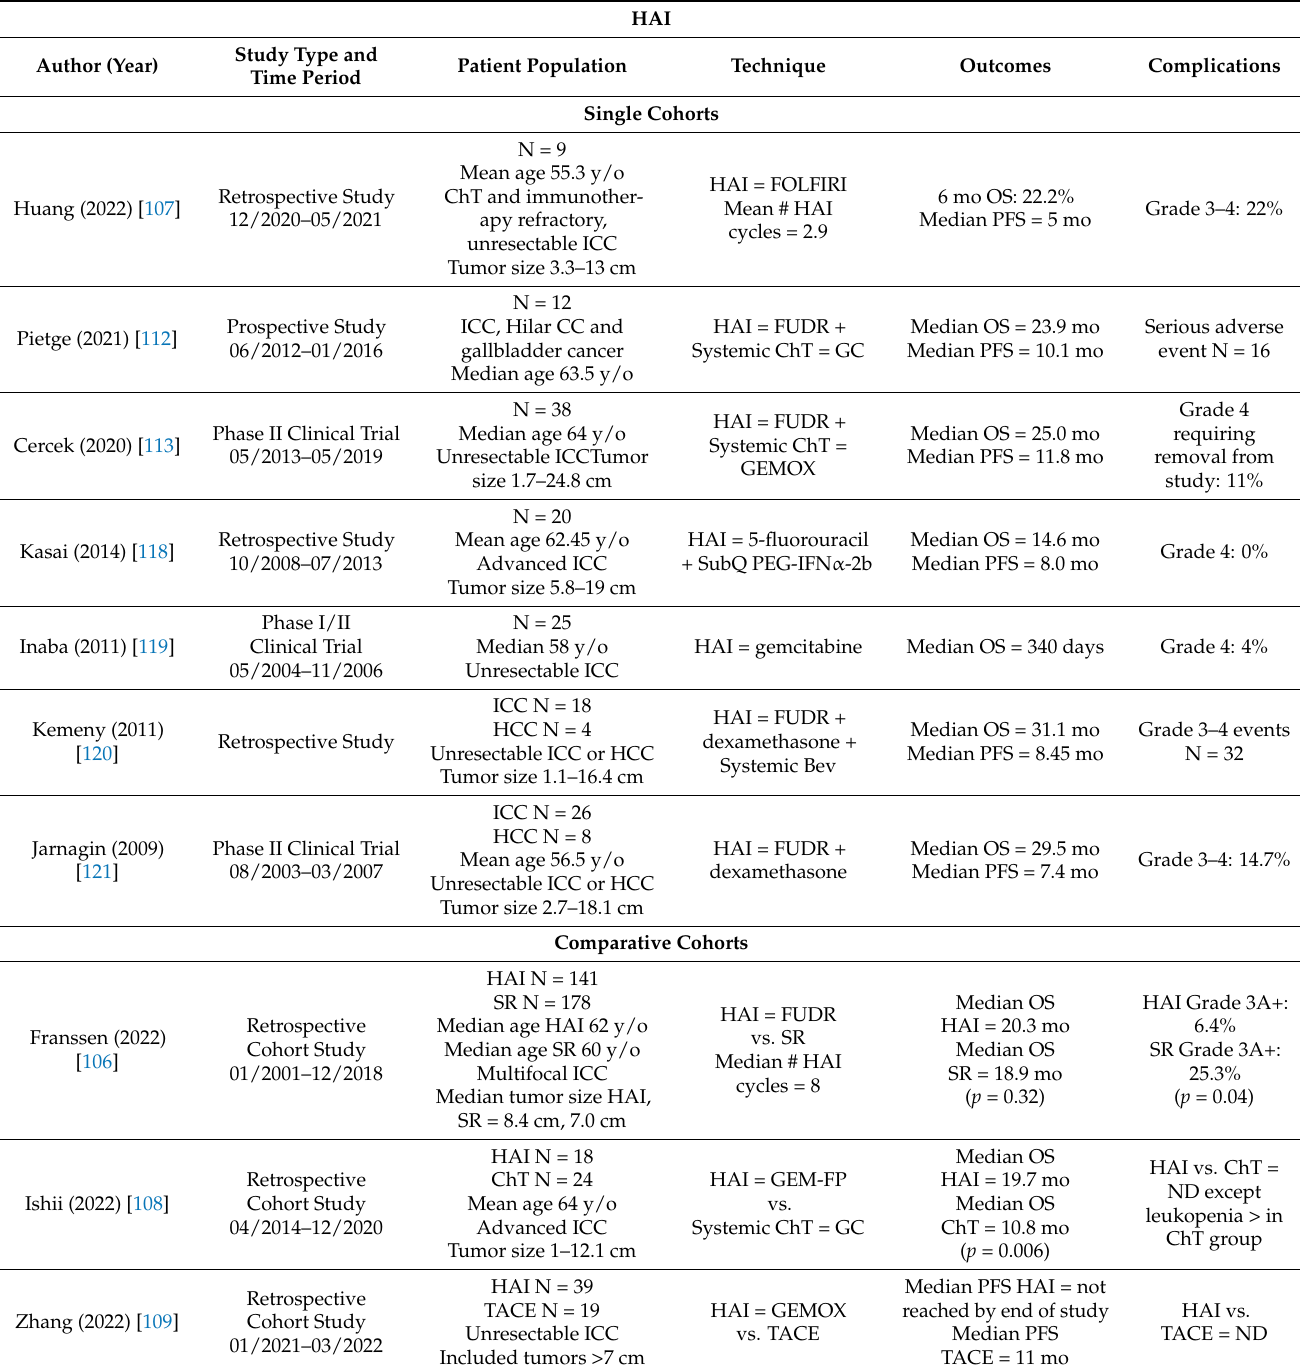
Table 7. Studies examining hepatic arterial infusion (HAI) for intrahepatic cholangiocarcinoma.